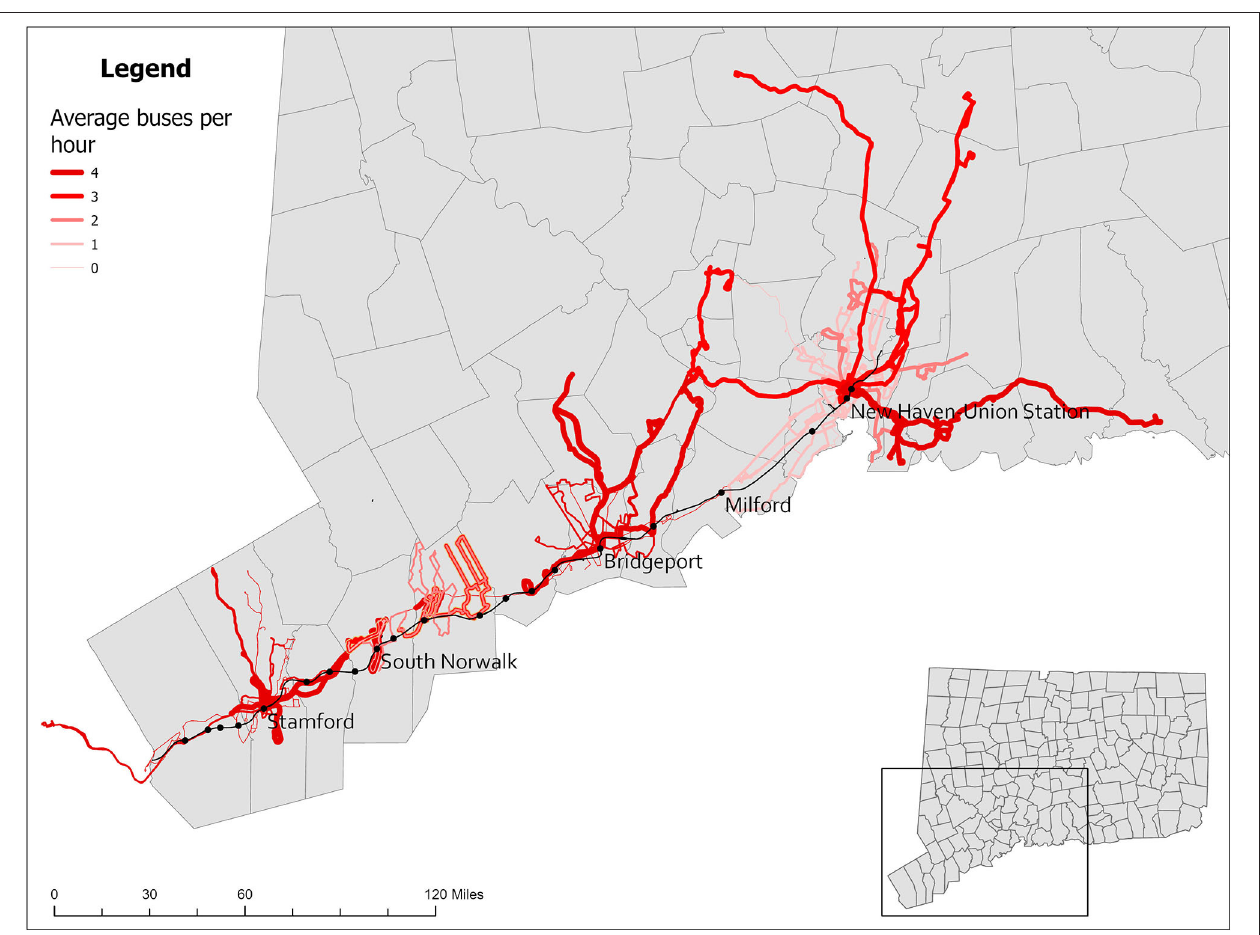
FIGURE 4 | Frequency map of bus service along the Metro-North